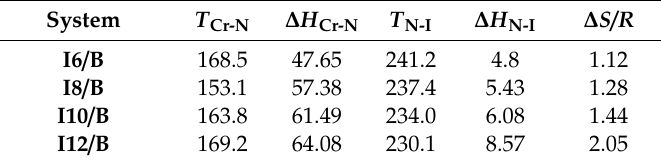
Table 1. Phase transition temperatures ( ◦ C), enthalpy of transitions (kJ / mol) and normalized transition entropy of supramolecular In / B